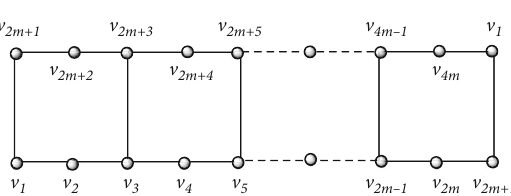
Figure 2: Hexagonal Möbius ladder graph HML